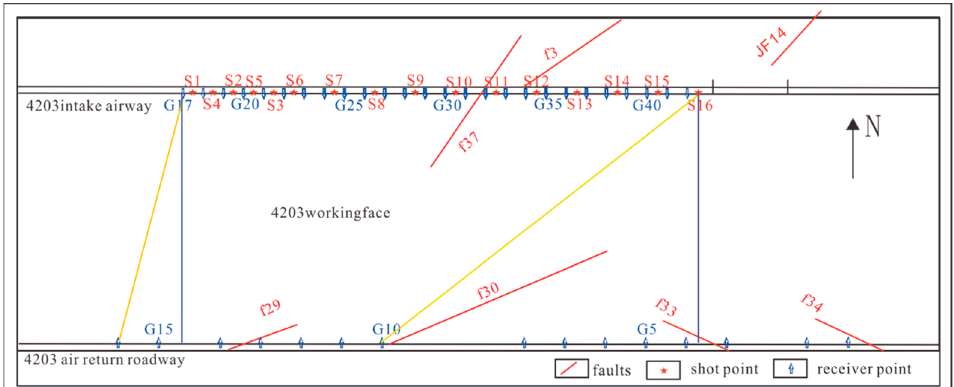
Figure 1. Arrangement diagram for a channel wave test performed on the 4203 working face.